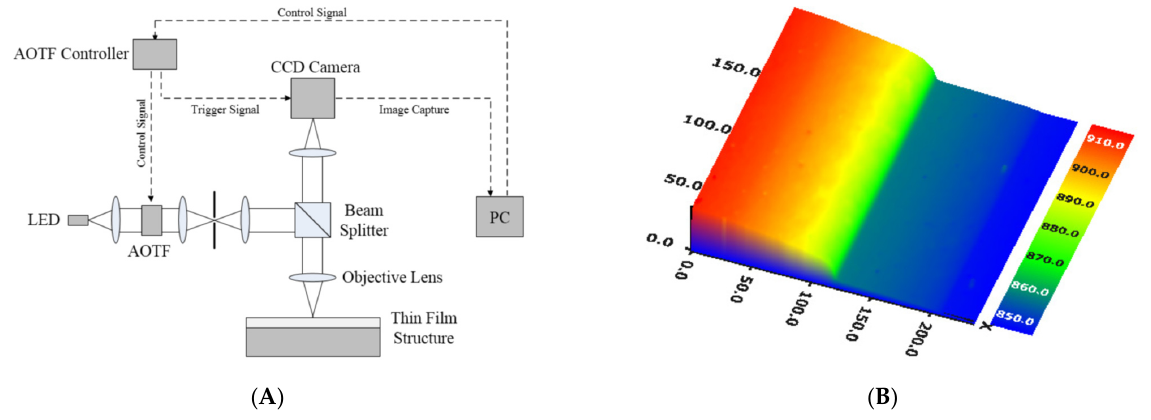
Figure 6. ( A ) Schematic of imaging spectroscopic reflectometry using an acousto ‐ optic tunable filter and ( B ) measurement result of 3D film thickness profile reprinted from Kim et al. Curr. Opt. Photonics 2017; 1: 29 ‐ 33 [40]; AOTF, acousto ‐ optic tunable filter.